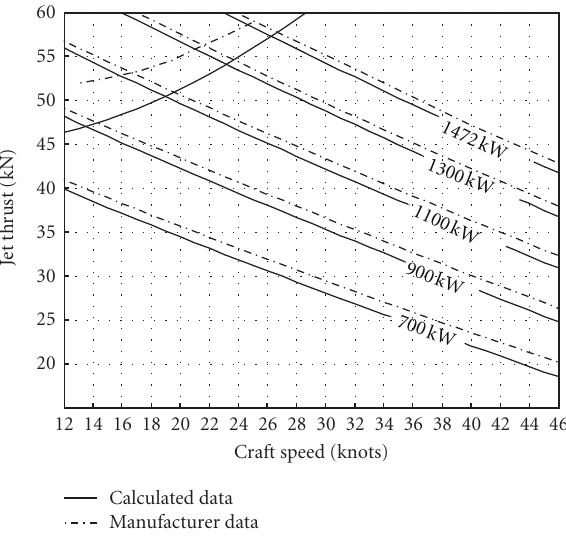
Figure 19: Thrust curves comparison with MJP